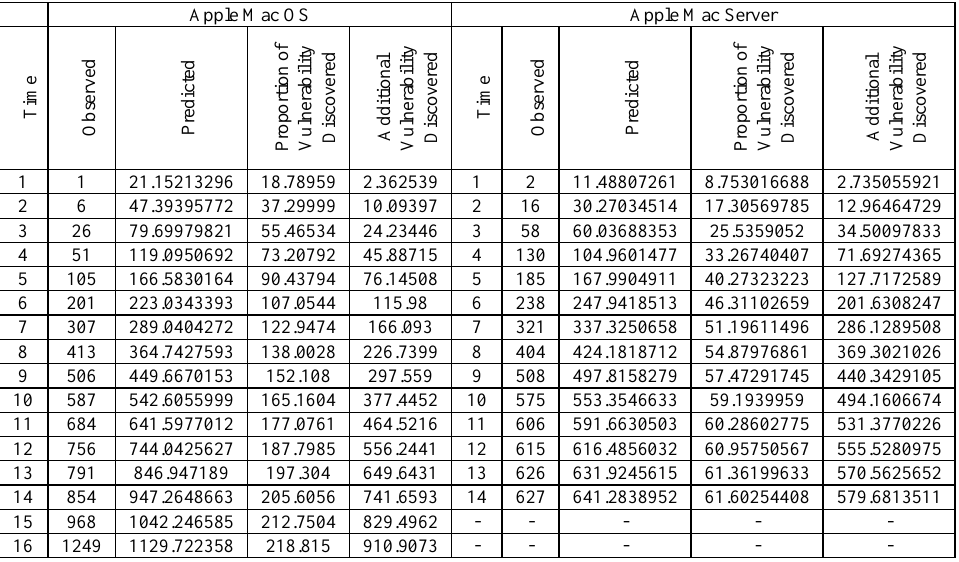
Table 4. Predicted and vulnerability proportions for Apple Macintosh